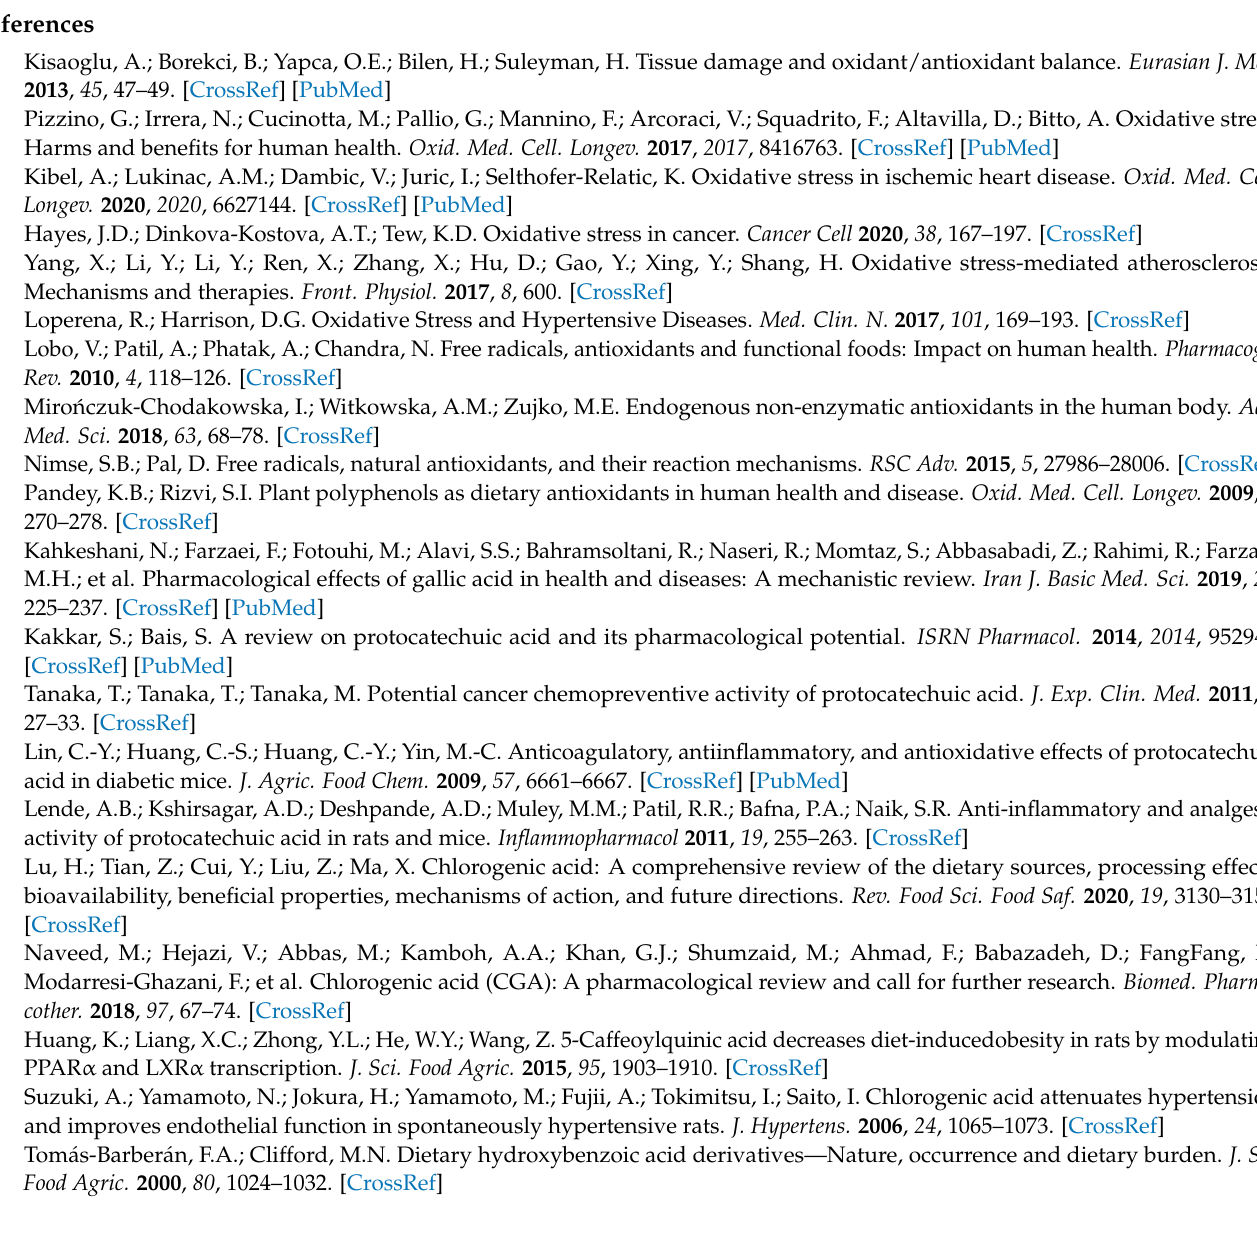
Figure A3. The DSC thermographs of antioxidant-loaded SBA-NH2 silica: ( a ) SBA-NH2-PCA; ( b ) SBA-NH2-CGA; ( c ) SBA-NH2-4HBA.